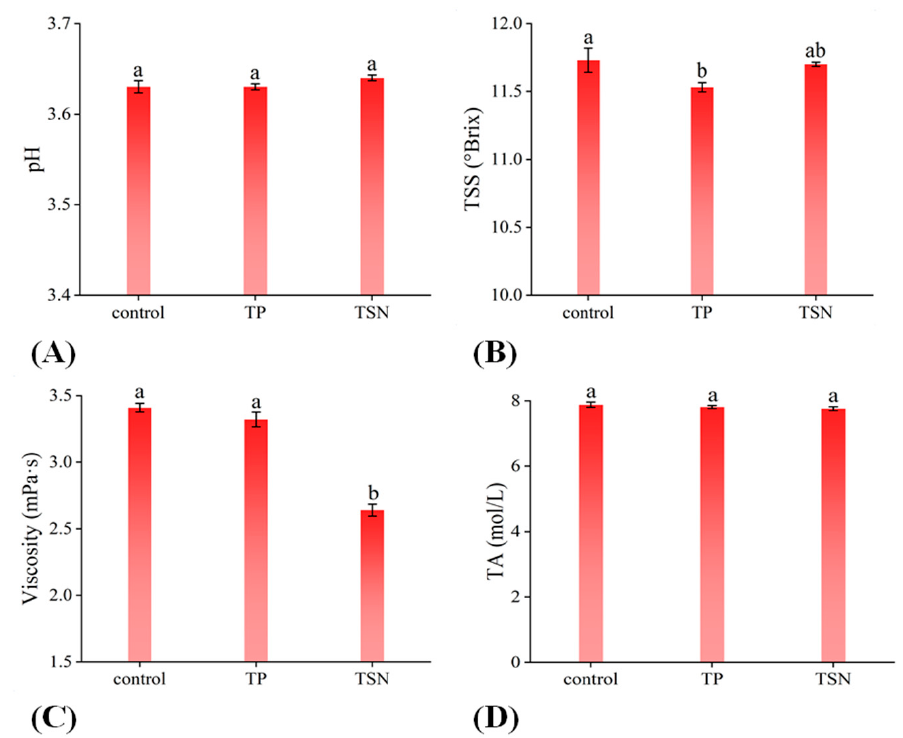
Figure 3. Effects of different sterilization treatments on the physicochemical properties of orange juice. ( A ) TSS; ( B ) pH; ( C ) viscosity; and ( D ) TA.